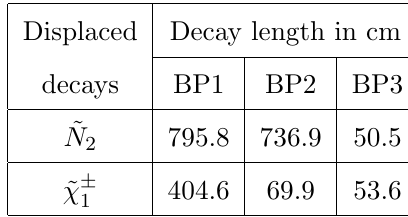
Table 2. The displaced decay length of ~ N 2 and ~ (cid:31) (cid:6)